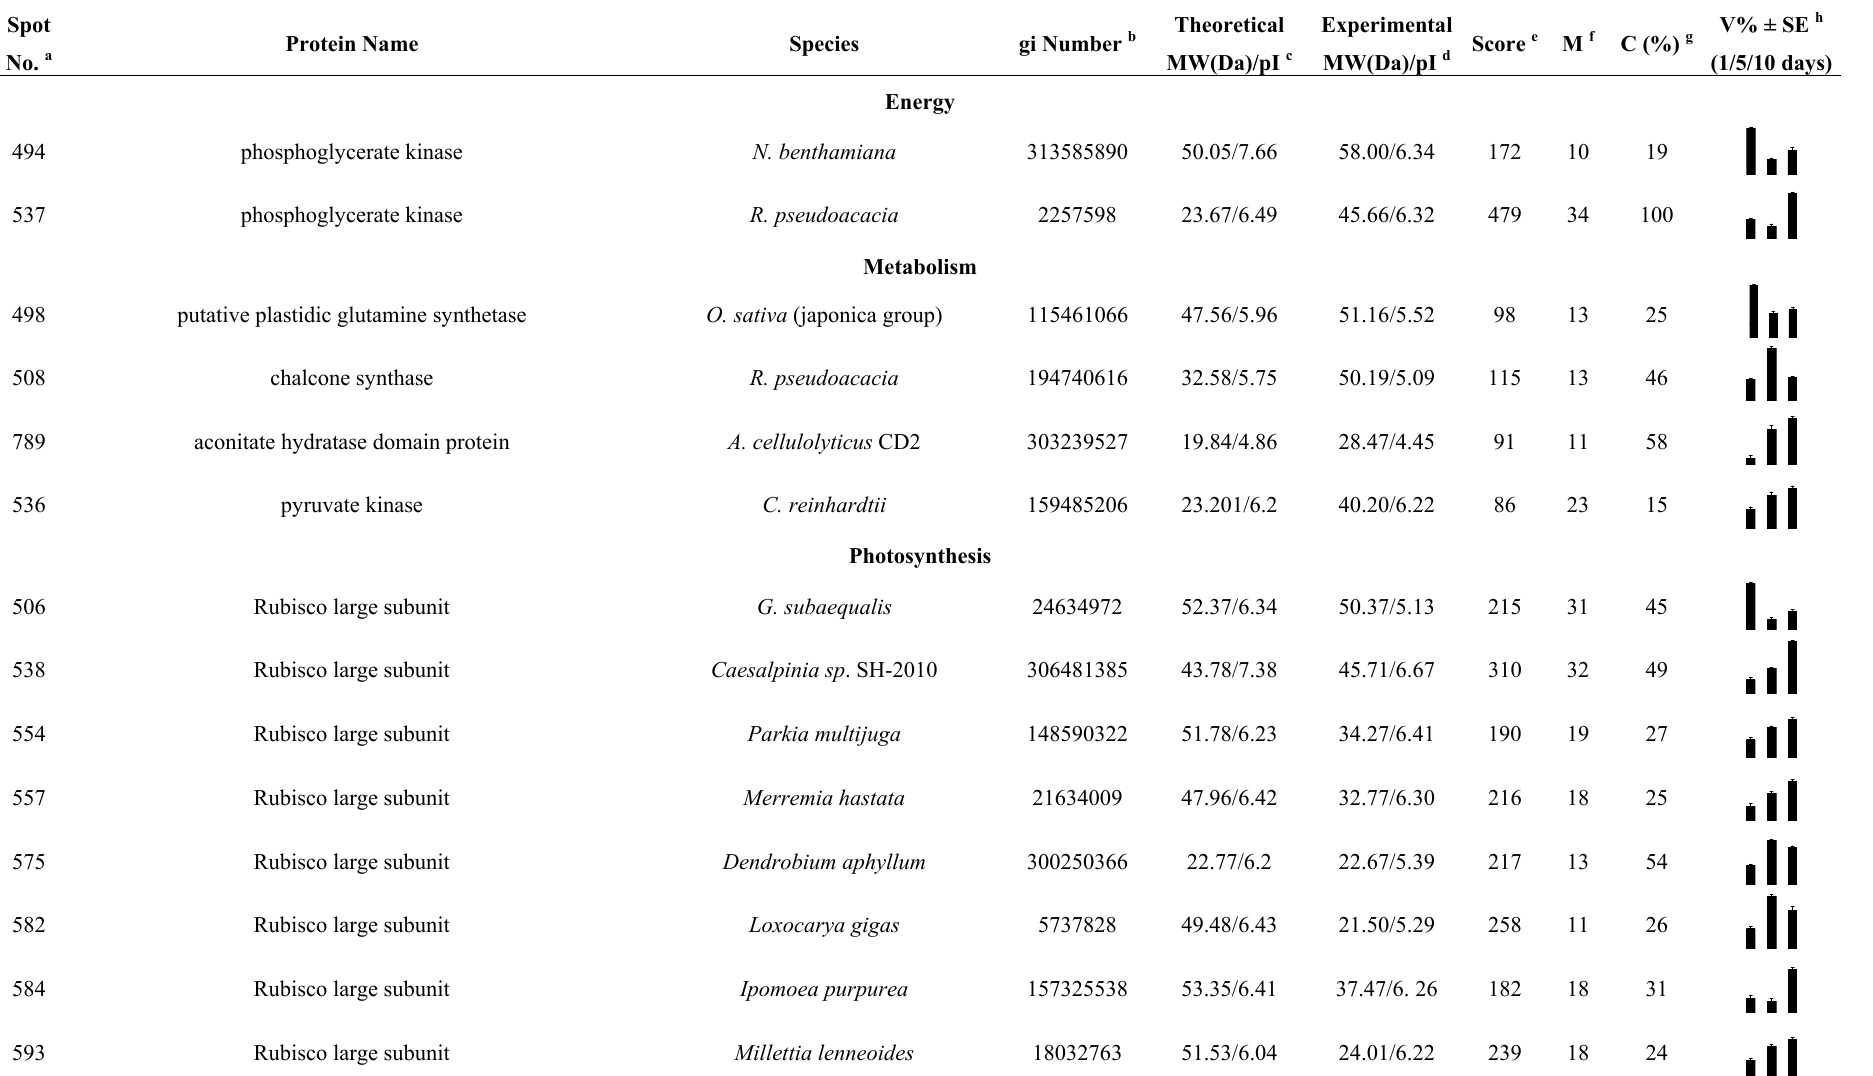
Table 1. Protein identities and their relative changes in leaves of tetraploid Robinia pseudoacacia after salt stress.